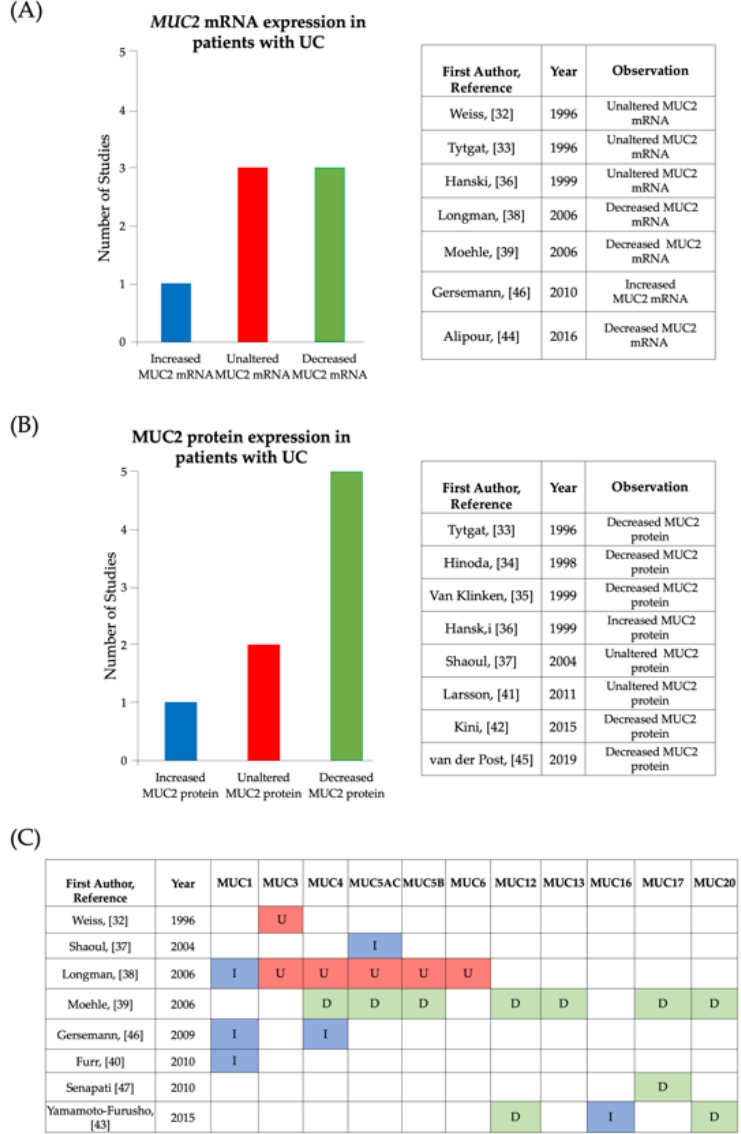
Figure 4. Summary of information reported in articles analyzing differences in mucin expression in active UC compared to controls. ( A ) Bar chart and table showing observations made by included studies that investigated MUC2 mRNA expression in active UC, with controls as baseline for comparison. ( B ) Bar chart and table showing observations made by included studies that investigated MUC2 protein expression in active UC, with controls as baseline for comparison. ( C ) Table showing observations made by included studies that investigated mucin expression levels of mucins other than MUC2. Key: I-Increased expression in comparison to controls, U-Unaltered expression in comparison to controls, D-decreased expression in comparison to controls.